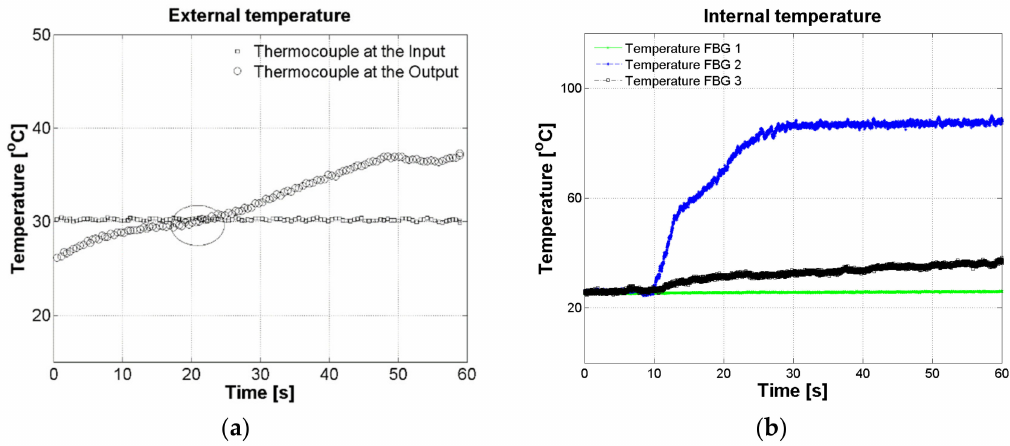
Figure 9. Temperature as function of time using water. ( a ) Outer temperatures measured by thermocouples in 60 s. ( b ) Inner temperatures measured by FBG temperatures sensors in 60 s. Blue and black lines indicate FBG 2 and 3 in contact with the water. Green line indicates FBG 1 the temperature inside the microwave